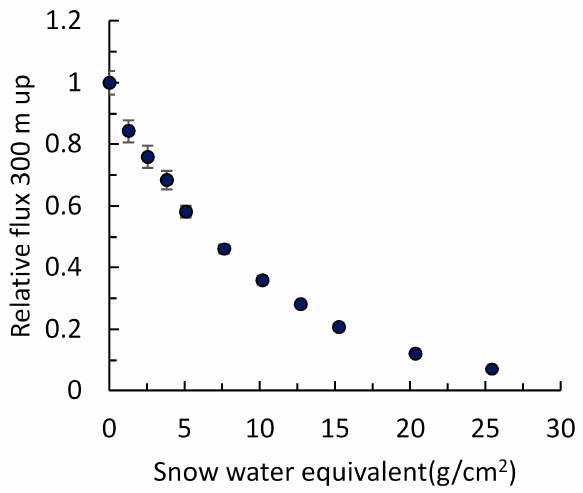
Figure 9. Relation between snow water equivalent and relative flux 300 m up calculated with PHITS2.